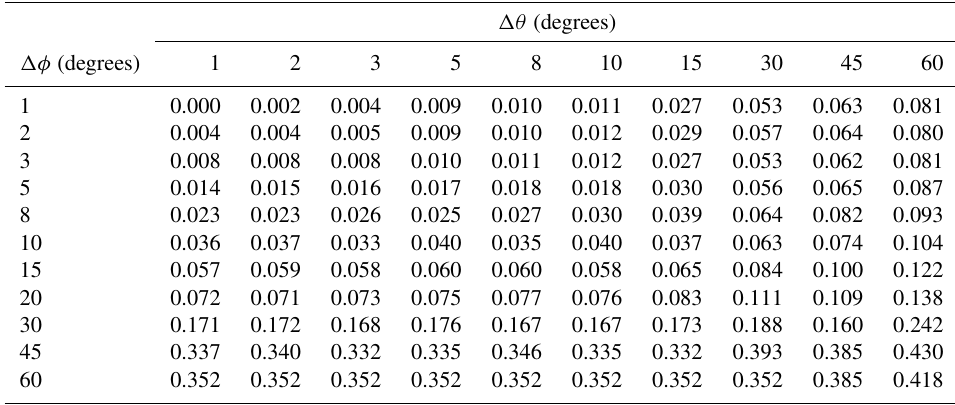
Table 1. Absolute maximum residuals (i.e., greatest residual within the DEM) for different combinations of (cid:49)θ and (cid:49)φ used in shielding calculations for a high relief basin in the